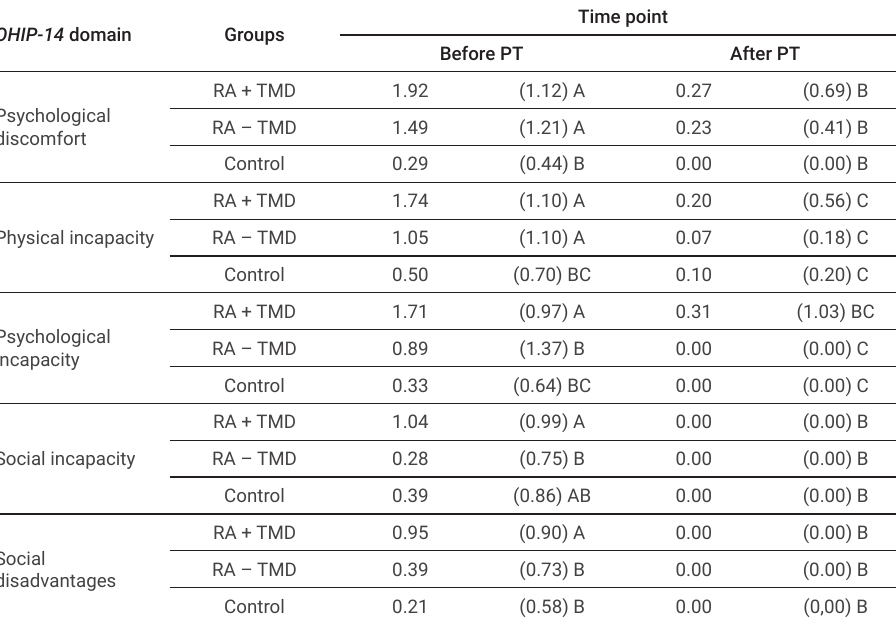
Table 2. Mean (standard deviation) of OHIP-14 domains with significant interaction between group and time